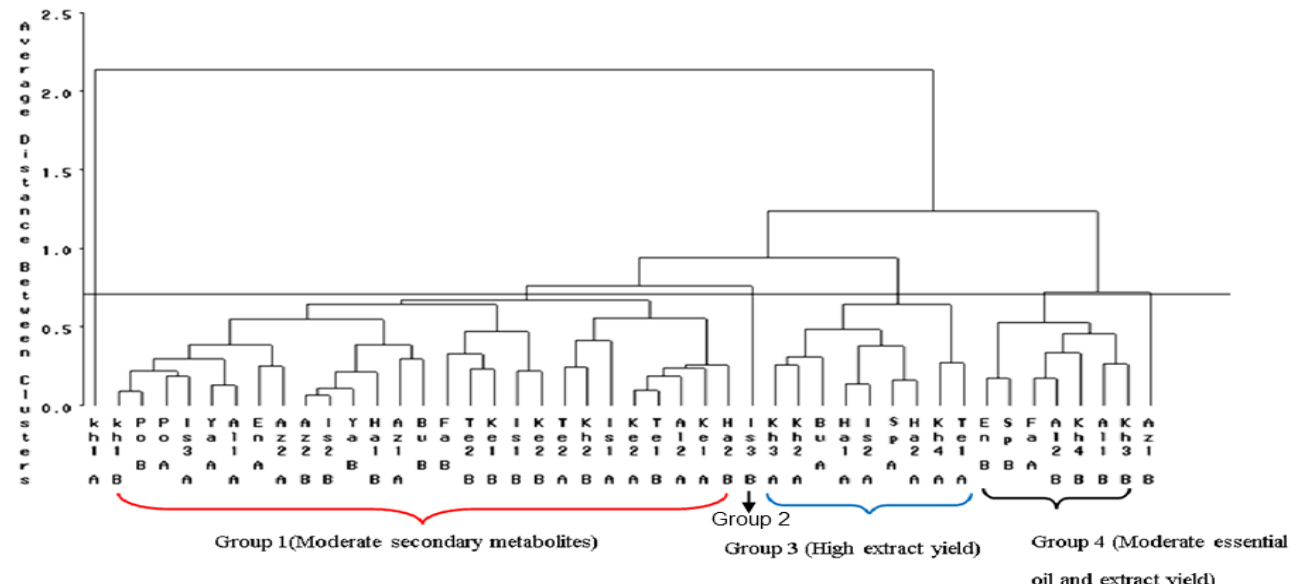
# Fig. 6: Grouping of outcross (A) and self-pollinated (B) fennel populations according to their secondary metabolites using Ward’s minimum variance. *The codes used in dendrogram were explained in Tab. 1.